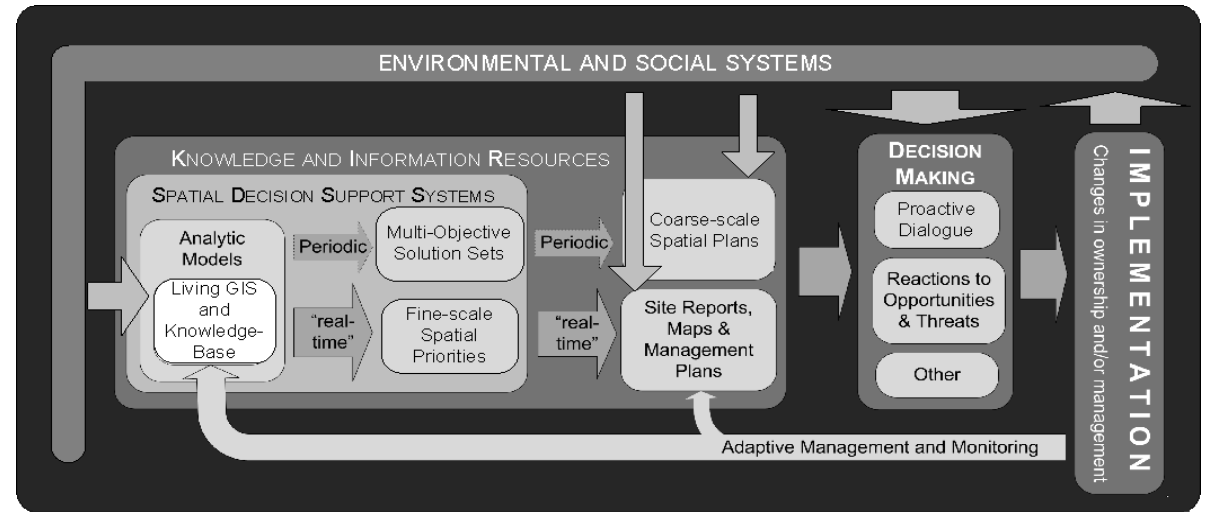
Figure 2. Multi-scale and contextual framing of a “living” SDSS. Ideally a “living” SDSS is able to incorporate new data from adaptive management and monitoring, and provide useful and user- friendly products at multiple scales.